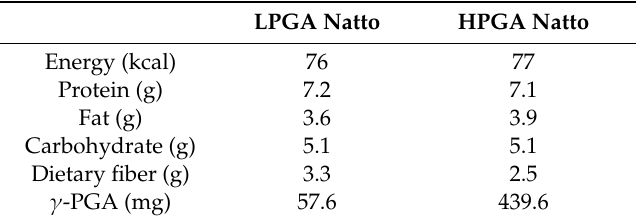
Table 1. Composition of the LPGA and HPGA natto per 40